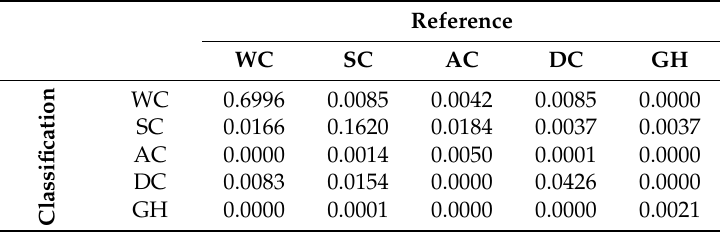
Table A2. Confusion matrix for variable subset “QRT_CMP_STM”. Cells populated with adjusted probabilities [54]. WC: winter cropping, SC: summer cropping, AC: semi-aquatic cropping, DC: double-cropping, GH: greenhouse cultivation.